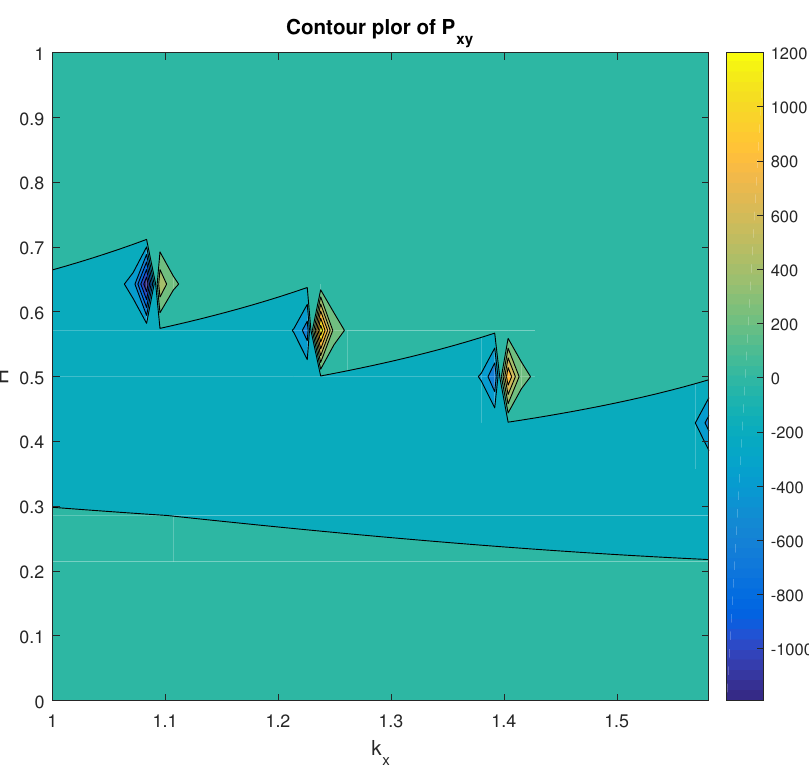
Figure 7. Contour plot of the dispersive coefficient component P xy . The variation is shown with respect to the quantum diffraction parameter H and wave vector ( k x ).